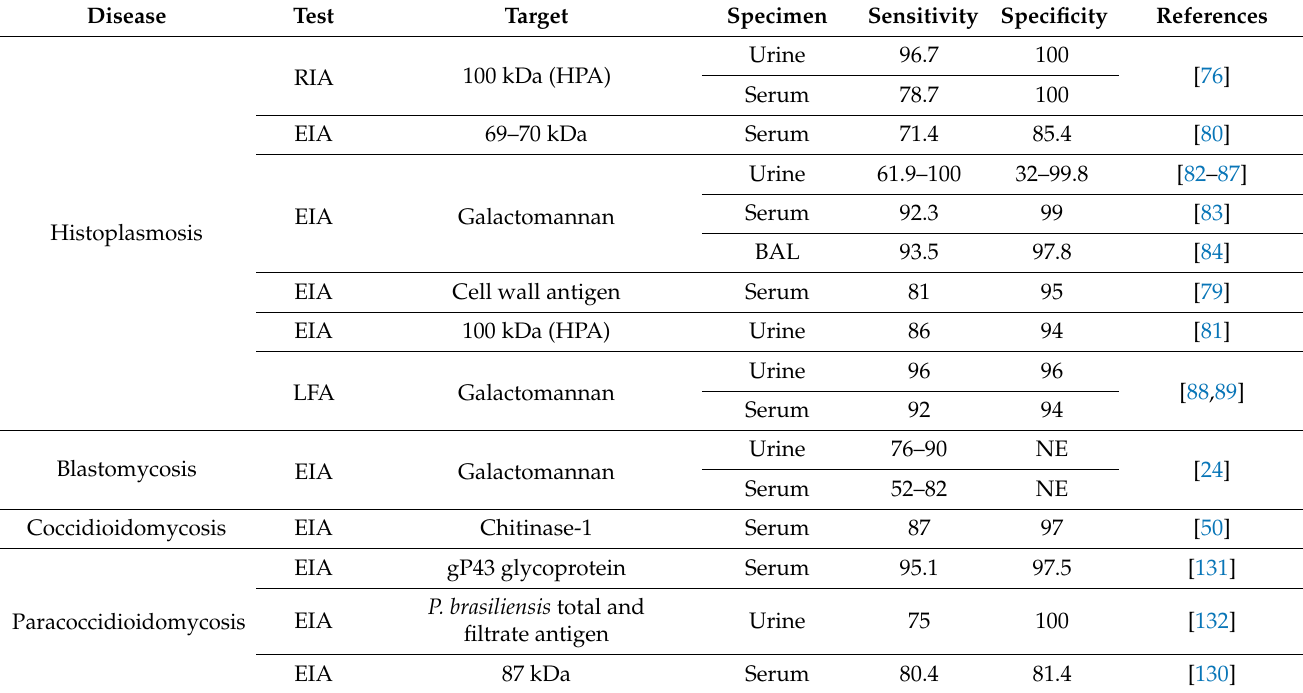
Table 3. Summary of sensitivity and specificity values of immunological tests used for diagnosis of endemic mycoses by antigen